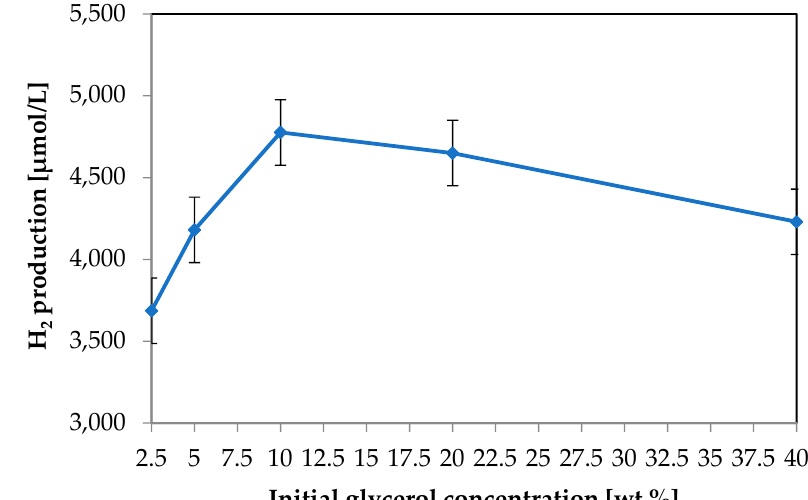
Figure 4. Photocatalytic hydrogen production during the irradiation time at different initial glycerol concentrations. Catalyst dosage: 1.5 g/L; solution pH: 6; visible light intensity: 32 mW/cm 2 ; photocatalyst: 1.08Cu_ZnO.